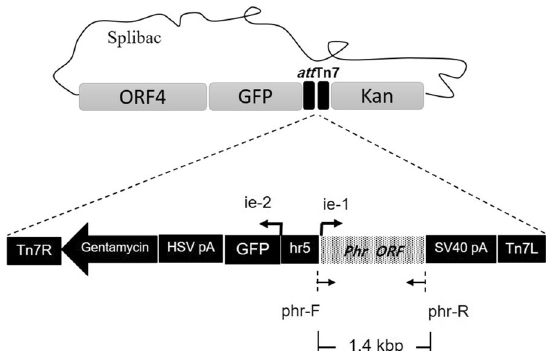
Fig. 2 Generation and evaluation of the recombinant virus Spli-phr carrying the photolyase gene in its genome. The drawing shows the location of the phr ORF under the control of ie1 promoter. Arrows shows the location of primers used for the verification of the selected clones to give a fragment of 1.4 kbp corresponding to the phr gene ORF in some clones